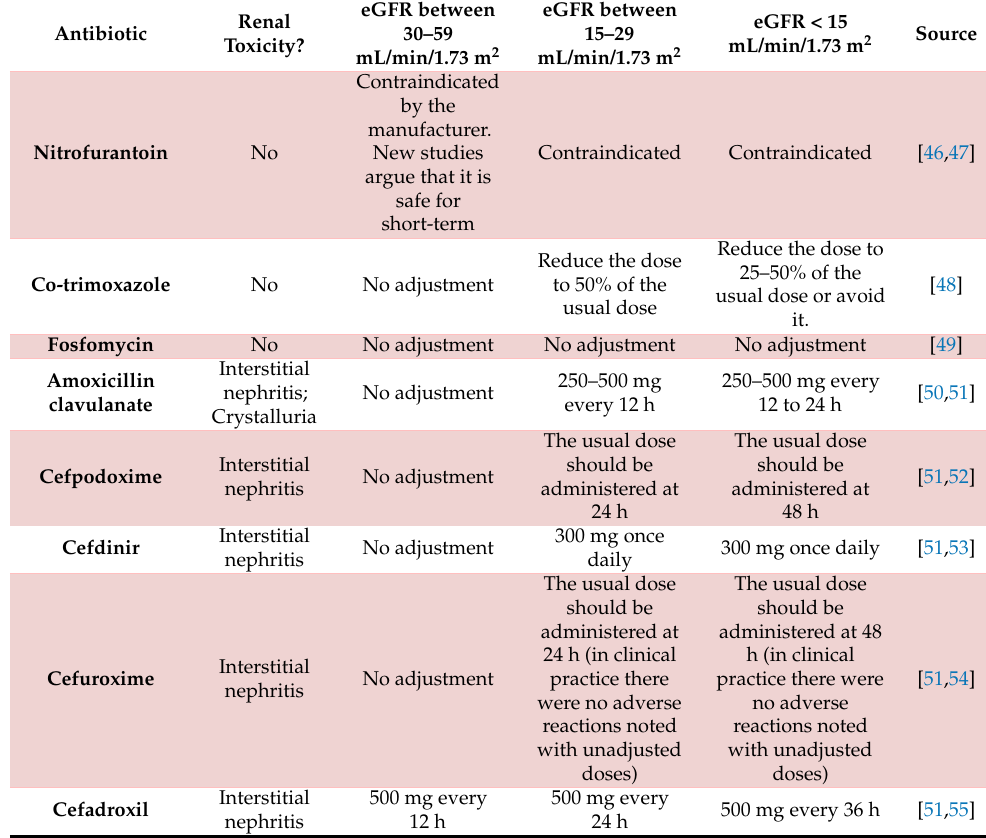
Table 3. Interrelations of antimicrobial drugs and